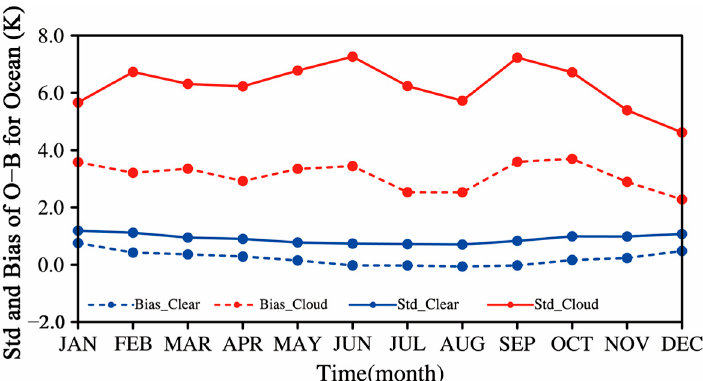
Figure 6. Monthly variations of OMB standard deviations (solid line) and bias (dotted line) for data in clear-sky (blue line) and cloudy-sky (red line) conditions over ocean from the 6.9-GHz-V channel in 2016.